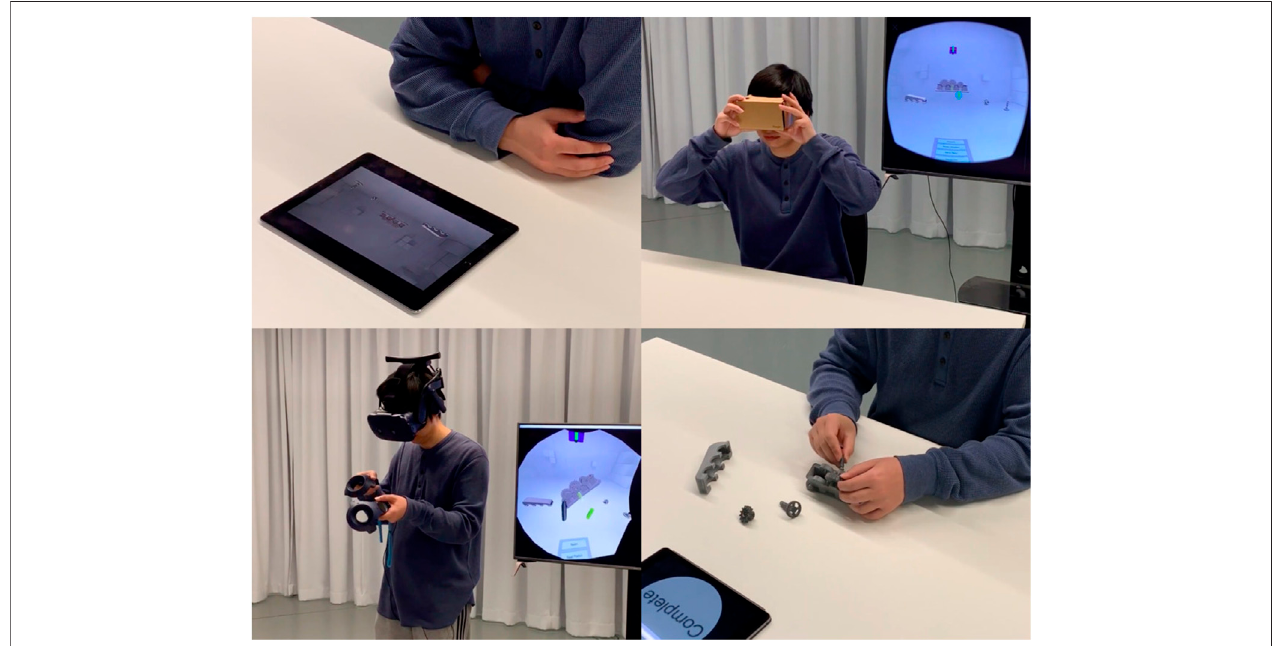
FIGURE 1 | A user learning assembly tasks in Video , Mobile VR , and PC VR conditions and assembling a 3D-printed gearbox on the table.